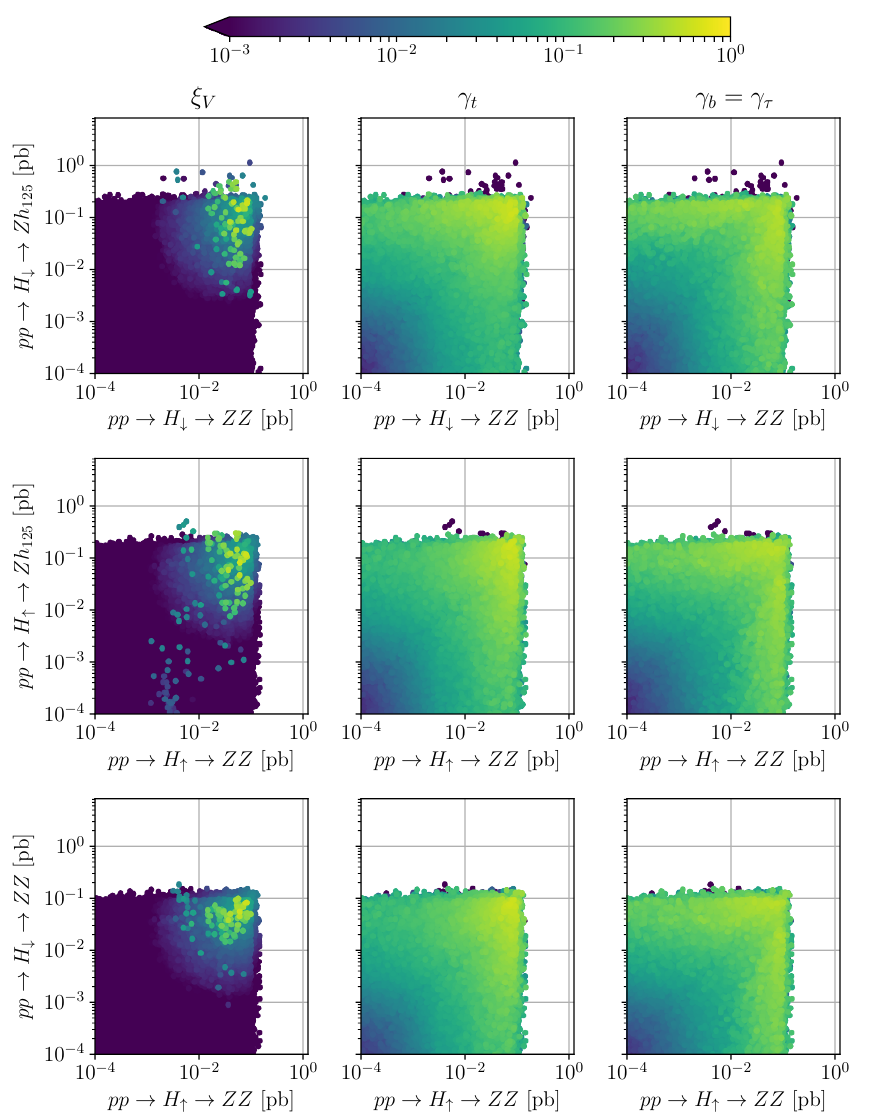
Figure 11 . Same as (cid:12)gure 10, but for Type